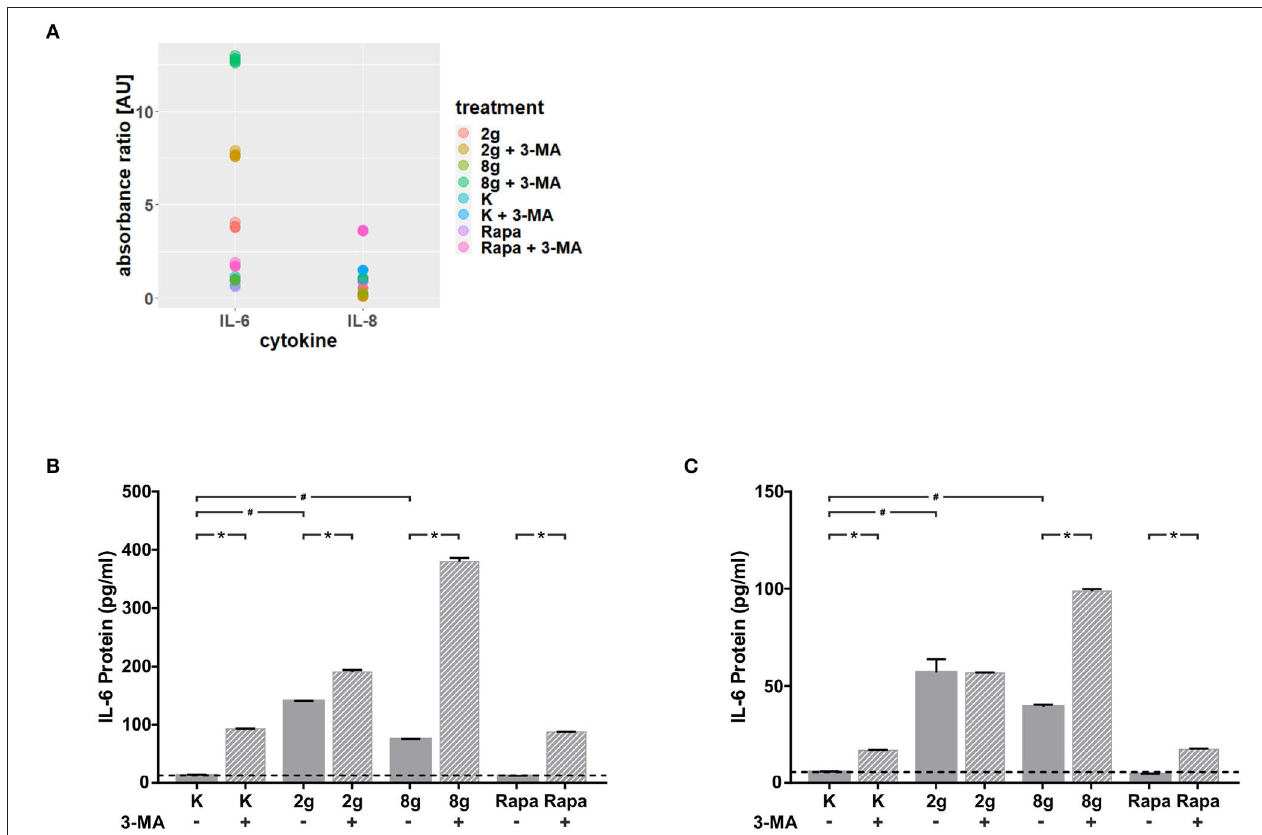
FIGURE 3 | (A) Absorbance ratios of examined cytokines with control groups above detection limit. Effects of mechanical stimulation (2 or 8 g/cm 2 ) or Rapamycin (Rapa; 50 nM) on cytokine levels in supernatants with or without autophagy inhibitor 3-MA at 16 h as determined by the Human Common Cytokines Multi-Analyte ELISArray TM Kit (Qiagen). Untreated cells served as control. (B) Effects of mechanical stimulation (2 or 8 g/cm 2 ) or Rapamycin (Rapa; 50 nM) on IL-6 protein level in supernatants with or without autophagy inhibitor 3-MA at 16 h as determined by ELISA. Untreated cells served as control. Mean ± SEM ( n = 12); # significant ( p < 0.05) difference between groups as determined by Dunnett’s T -test. ∗ significant ( p < 0.05) difference between two groups (uninhibited and inhibited) as determined by the Mann-Whitney-Test. (C) Effects of mechanical stimulation (2 or 8 g/cm 2 ) or Rapamycin (Rapa; 50 nM) on IL-6 protein level in supernatants with or without autophagy inhibitor 3-MA at 24 h as determined by ELISA. Untreated cells served as control. Mean ± SEM ( n = 12); # significant ( p < 0.05) difference between groups as determined by Dunnett’s T -test. ∗ significant ( p < 0.05) difference between two groups (uninhibited and inhibited) as determined by the